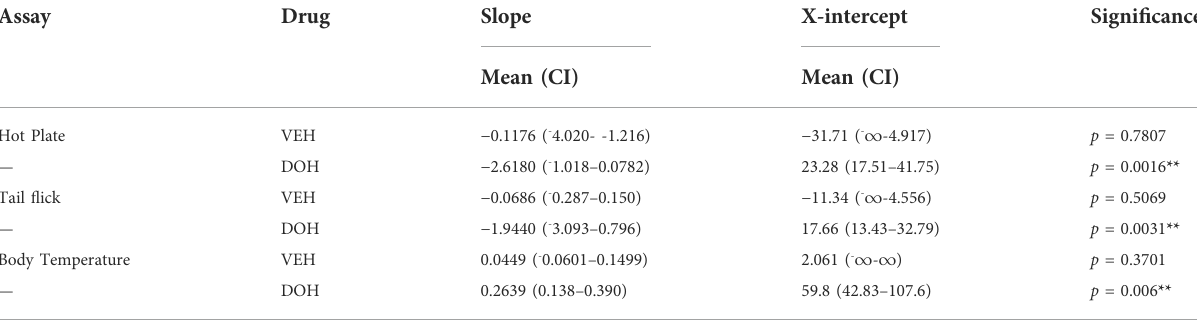
TABLE 2 Calculated slopes (mean +95% con fi dence intervals) and x-intercepts for the acute antinociceptive and hypothermic effects of vehicle (VEH)- and decursinol (DOH)-treated groups across day. Linear regression analyses were used to determine the slopes from the daily tolerance curves following once-daily treatment with either vehicle (VEH) or decursinol (DOH) across 14 days. The slopes were extrapolated to determine the x -intercept indicative of when the response following treatment would be 0. Values shown are the slopes and extrapolated x-intercepts and 95% con fi dence intervals for vehicle and decursinol treated mice (N = 12/group). ∞ = values that could not be calculated/were listed as in fi nity. Signi fi cance denotes a signi fi cant difference in the slope from